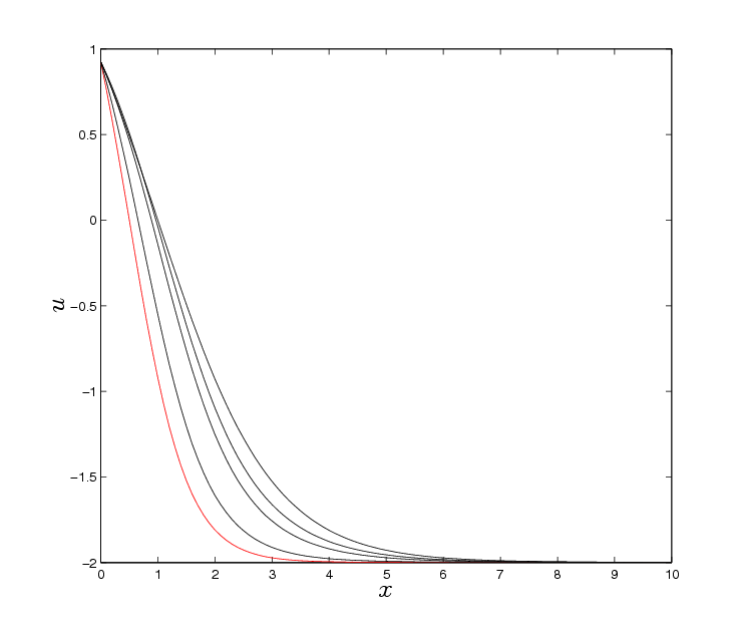
Figure 3: Graph of the numerical solution of QP in the ( x , u = v ) plane for u b = 1 and u + = −2 at times t = 5, 10, 15, 20 and 25 . We note that the exact SS is shown via the red line at t = 25 .